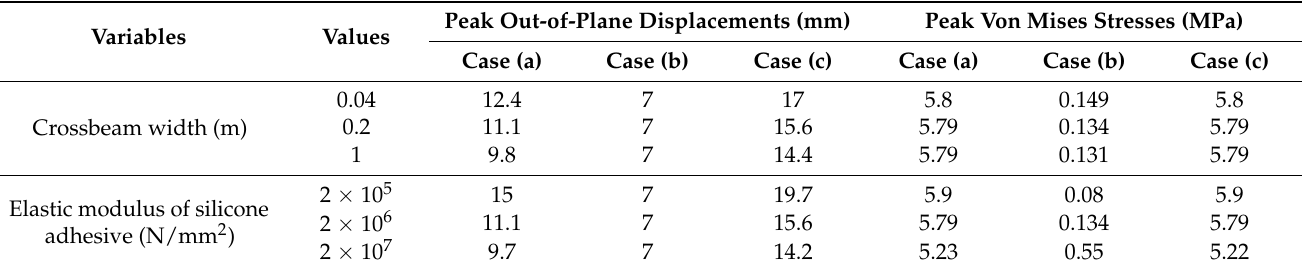
Table 5. Peak responses of the